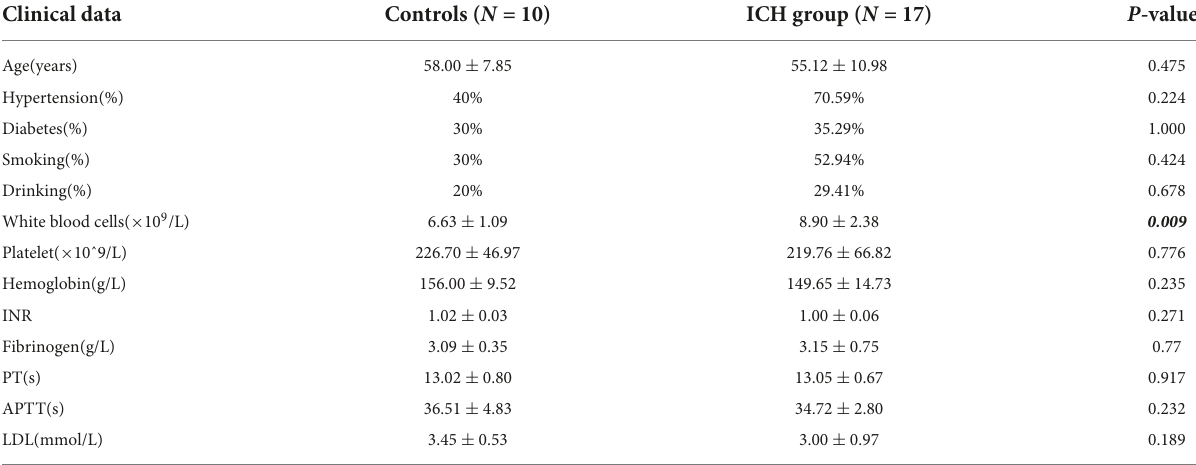
TABLE 1 Comparison of clinical data between ICH group and